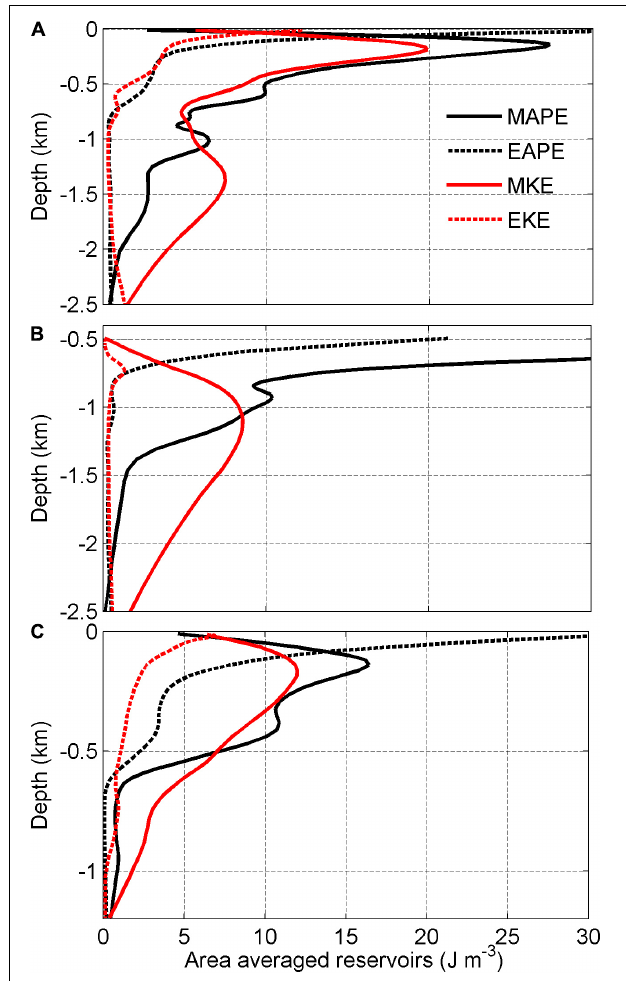
FIGURE 5 | Vertical profiles of area average MAPE (J m − 3 ), EAPE (J m − 3 ), MKE (J m − 3 ), and EKE (J m − 3 ) over the whole AIS cavity (A) , region AIS1 (B) , and region AIS2 (C)